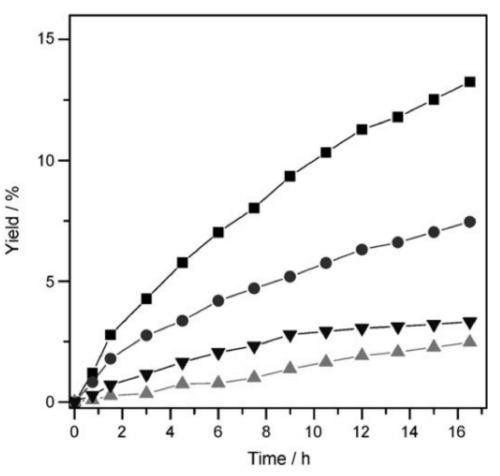
Figure 8. Yield versus time curves for cyclohexene oxidation with MFU-2 as the catalyst. (cid:4) : total conversion, • : tert -butyl-2-cyclohexenyl-1-peroxide, (cid:78) : 2-cyclohexen-1-one, (cid:72) : cyclohexene oxide. Reproduced with permission from [48].